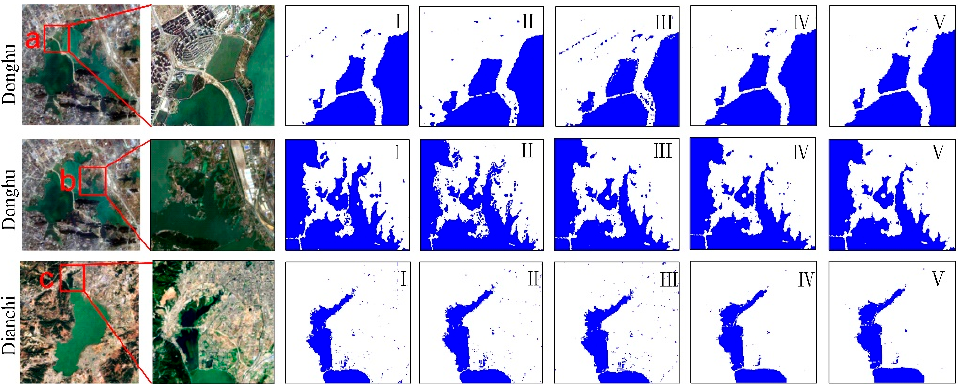
Figure 10. Comparison of LWB extraction in urban lakes across Methods I–V. The subs ( a – c ) of Figure 10 are used to show the differences among the extraction results.